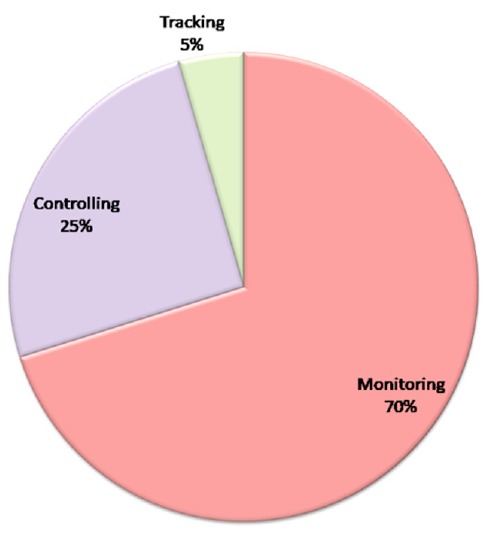
Figure 4. Application Domains.